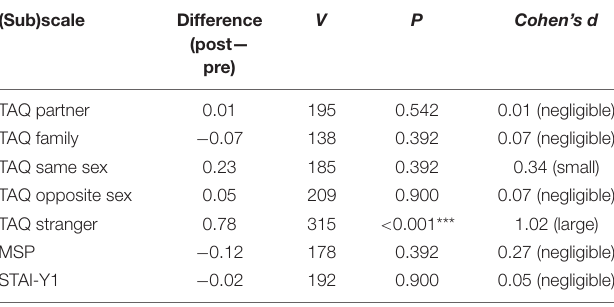
TABLE 1 | Pre-post comparisons for the scores on each subscale.